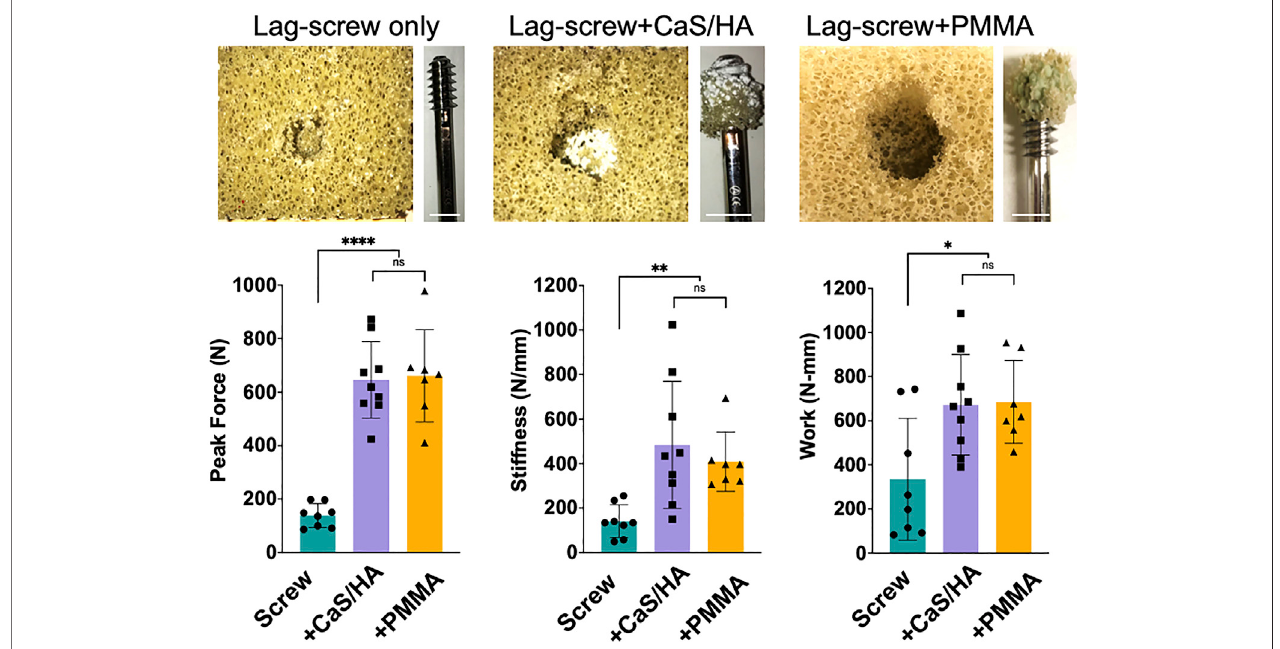
FIGURE 4 | Mechanical effects of CaS/HA augmentation on lag-screw anchorage in Sawbones (Top) Shows photographs of the Sawbones block and the lag- screw after the pull-out test. Notice the spreading of the CaS/HA material in the pre-drilled hole and the presence of both CaS/HA and PMMA biomaterial-Sawbones compositeonthelag-screwsafterpull-outtesting(Bottom)Scatterplotsshowingmeanpeakforcetopull-outthescrew,thestiffnessandworkrequireduntilthefailureof thescrewsintheSawbonesmodel.*Indicates p < 0.05,**indicates p < 0.01and****indicates p < 0.0001.nsindicatesnotsigni fi cant.Scalebarindicates1.3 cm.